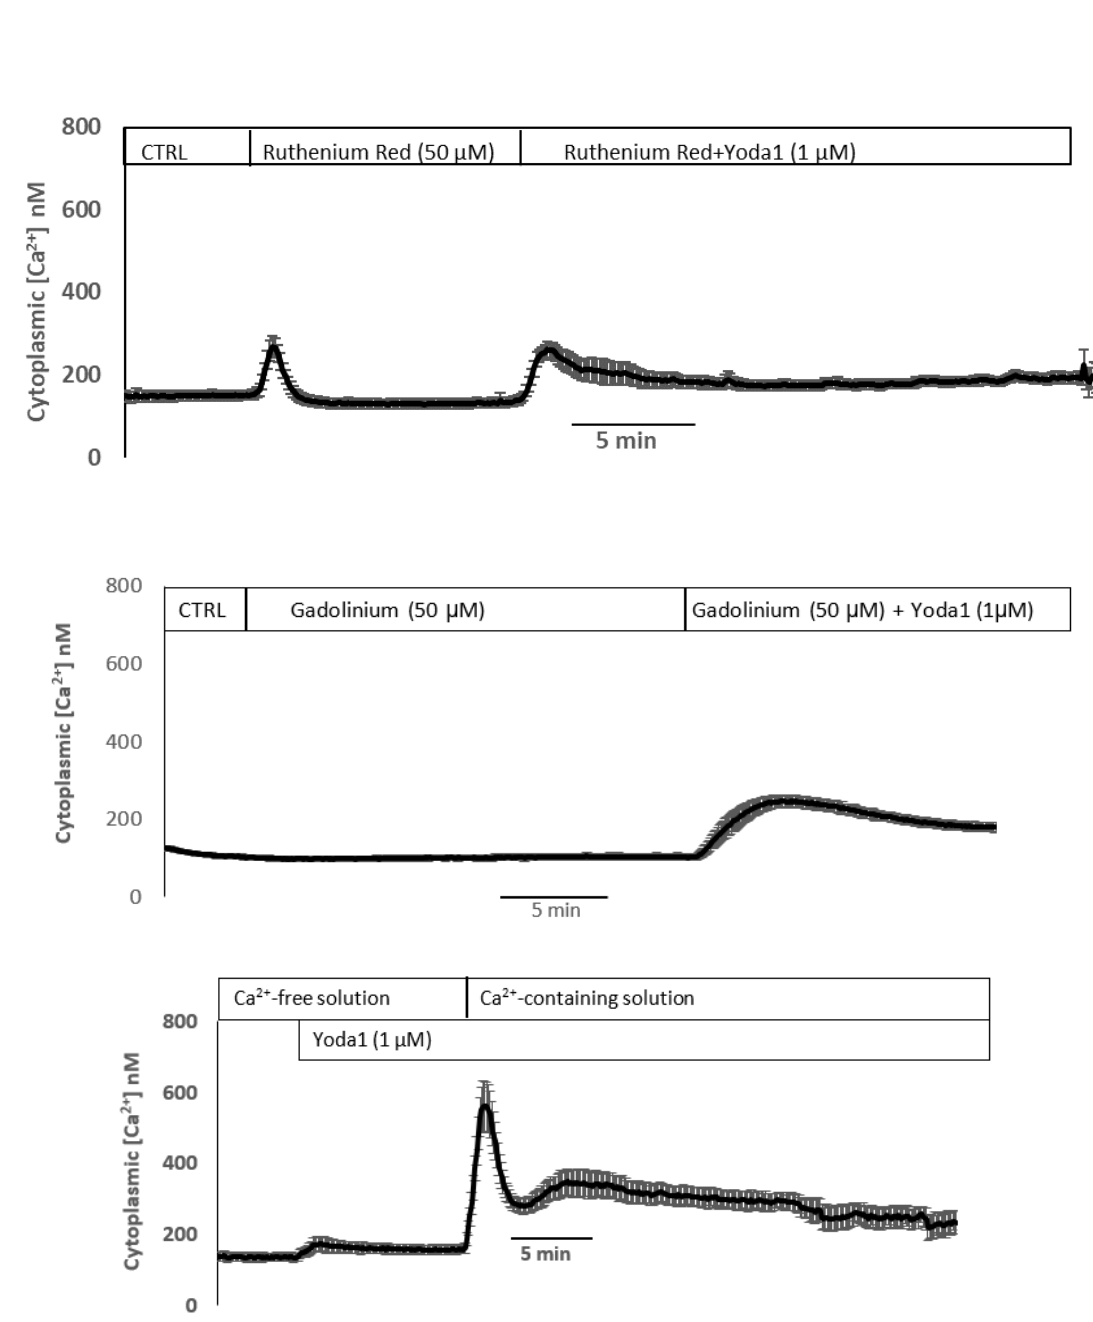
Figure 8. ( A ) The cytoplasmic calcium response to Yoda1 in control conditions, ( B ) subsequent exposure to ionomycin, ( C ) in the presence of ruthenium red or ( D ) gadolinium, ( E ) in a calcium-free solution. Cultured lens epithelial cells loaded with Fura2 were first superfused with a control Krebs solution, then Yoda 1 (1 µ M) was introduced. Some cells received ruthenium red (50 µ M) before Yoda 1 was added in the continued presence of ruthenium red. Gadolinium (50 µ M) experiments were carried out in a similar manner, although a bicarbonate-free HEPES-buffered Krebs solution was used. The values shown are the mean ± SEM of results from 6–10 independent experiments, where each individual experiment was the average of 15–30 individual cells.